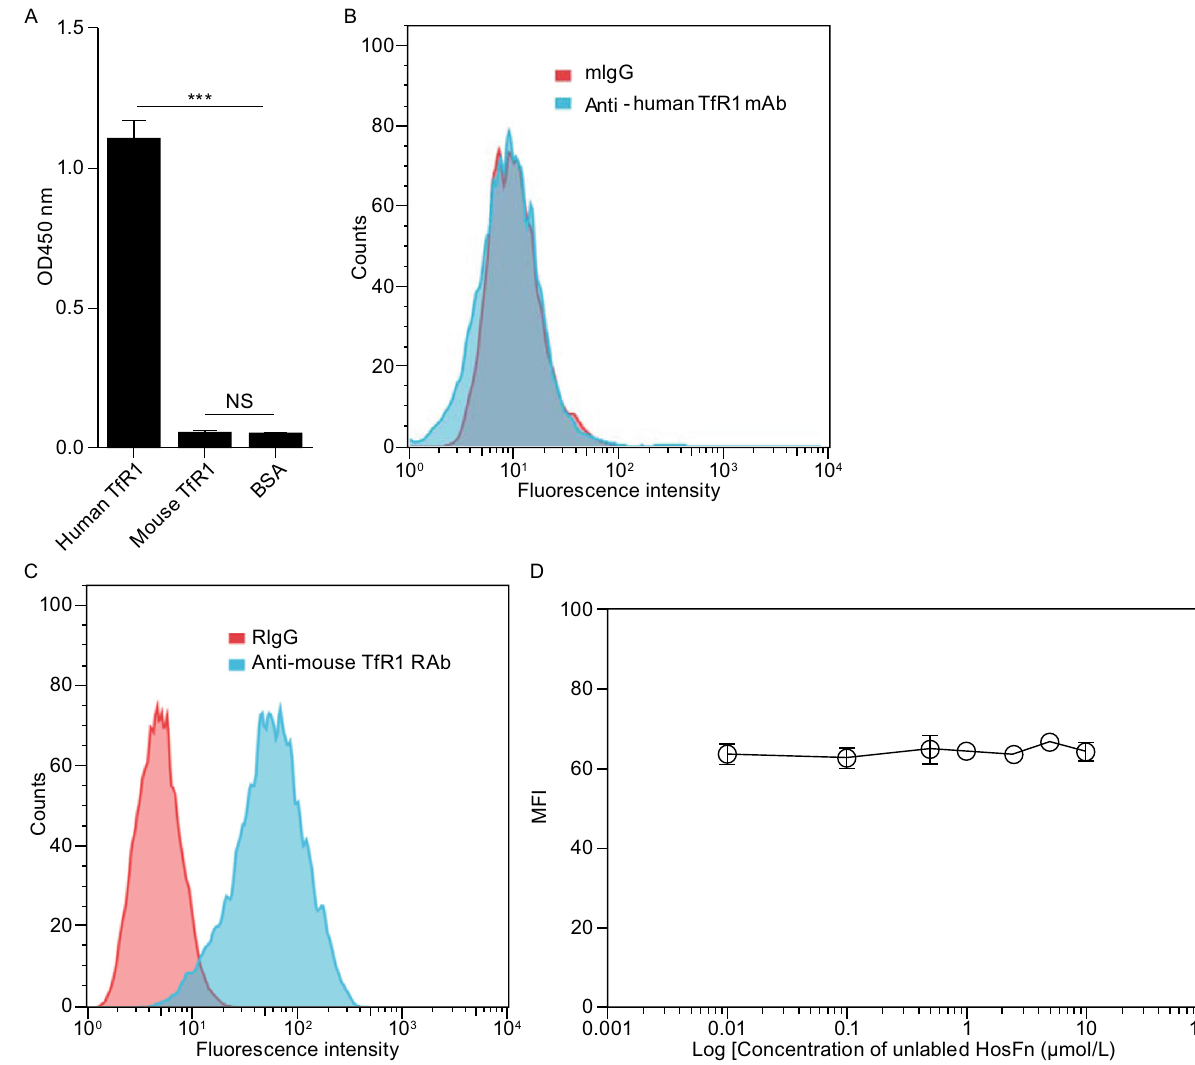
Figure 1. Lack of interaction between HosFn and mouse BBB endothelial bEnd.3 cells. (A) ELISA analysis of the binding of mouse anti-human TfR1 mAbs (Clone M-A712; BD Bioscience) to human TfR1 (11020-H07H, Sino Biological) and mouse TfR1 (50741-M07H, Sino Biological). (B) Flow cytometry analysis of the binding of mouse anti-human TfR1 antibody (Clone M-A712; BD Bioscience) to bEnd.3 cells. (C) Flow cytometry analysis of the binding of rabbit anti-mouse TfR1 antibody (50741-T16; Sino Biological) to bEnd.3 cells. (D) Competition for the binding sites of FITC-labeled HosFn (0.1 μ mol/L) on bEnd.3 cells by unlabeled